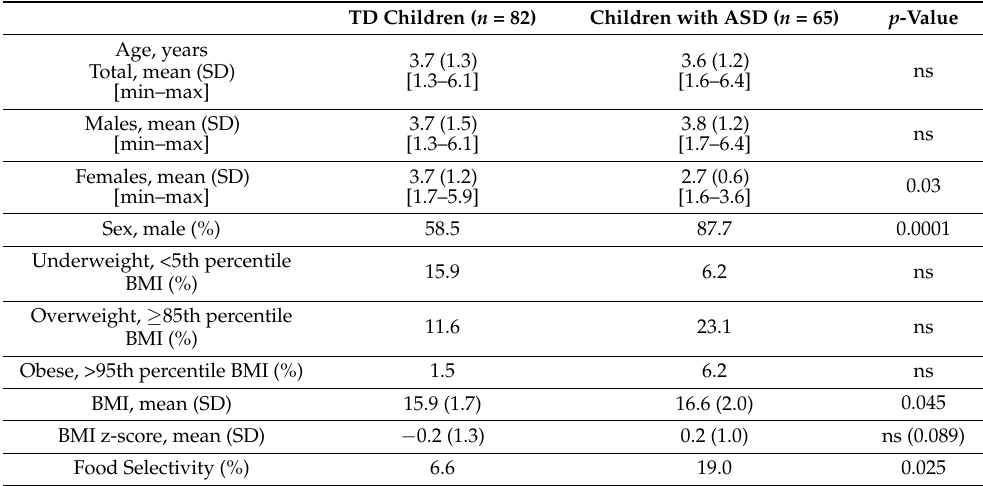
Table 2. Participant characteristics of children with autism spectrum disorder and typically develop- ing children.